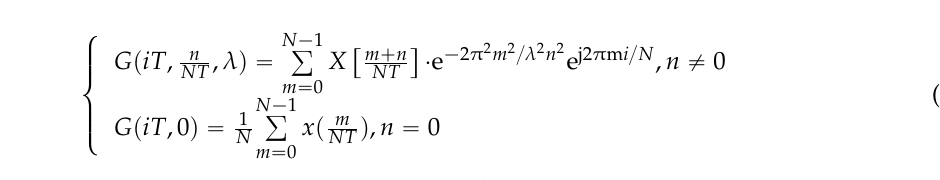
Table 1. Parameters of the simulated UHF PD signals.